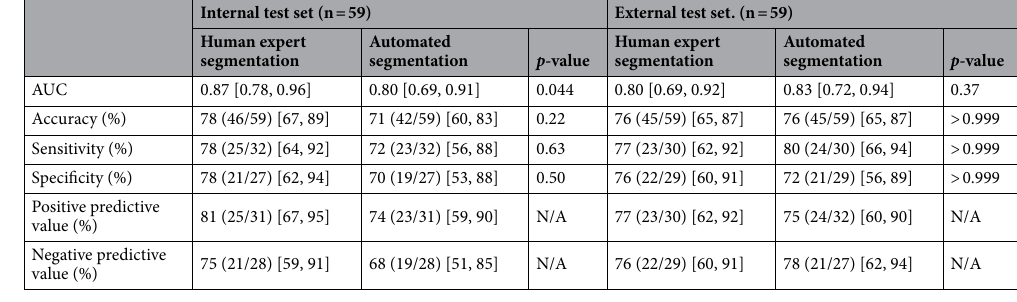
Table 5. Diagnostic performance of the radiomics prediction model. Numbers in brackets indicate 95% confidence